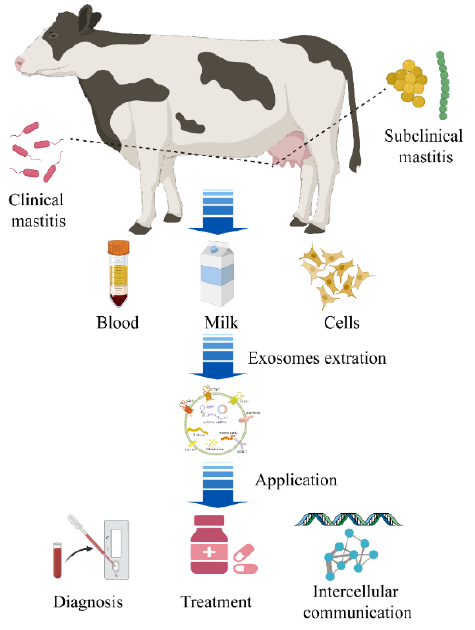
Figure 1. Mastitis-related exosomes for diagnosis, treatment, and disease mechanism analysis. The main pathogen in clinical mastitis is gram-negative bacteria represented by Escherichia coli , and the main pathogens in subclinical mastitis are gram-positive bacteria represented by Streptococcus spp. and Staphylococcus spp. Exosomes have been found in milk, blood, and cell supernatant, and nucleic acids, proteins, and metabolites encapsulated by exosomes are source-specific and stable. In mastitis, exosomes show great application potential for early diagnosis, targeted therapy, and disease mechanism